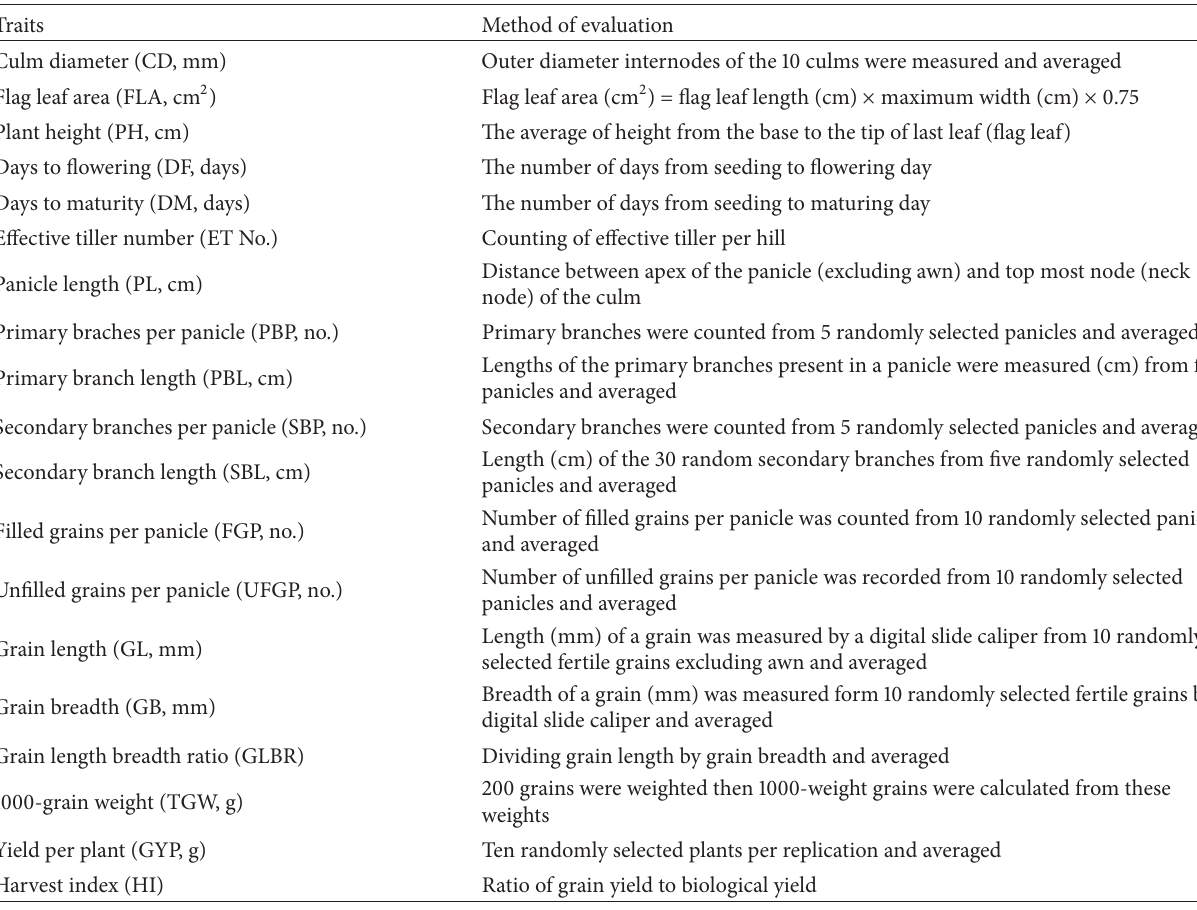
Table 2: List of quantitative traits of 113 aromatic and fine rice